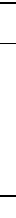
Figure 2. Cytotoxicity and caspase activity ( A ) Semiconfluent cultures of SW480 were exposed to the indicated concentrations of M , 1 , 2 , OH-XB and XB. Viability was determined after 48 h by neutral red uptake assay and MTT assay. The results are the mean ± SD pooled from four independent experiments ( n = 4) performed in five-fold measurements. M , 1 , and 2 were less active than XB and OH-XB at p < 0.0001 according to two-way ANOVA of Data. ( B ) Protein lysates were harvested 48 h after exposure to 15 µM of M , 1 , 2 , OH-XB and XB and prepared to measure caspase activity. The results are the mean ± SD pooled from three independent experiments ( n = 3) performed in duplicate. **** indicates a significant difference from control at p < 0.0001. Table 4. Sensitivity of SW480 cells to M , 1 , 2 , OH-XB and XB.